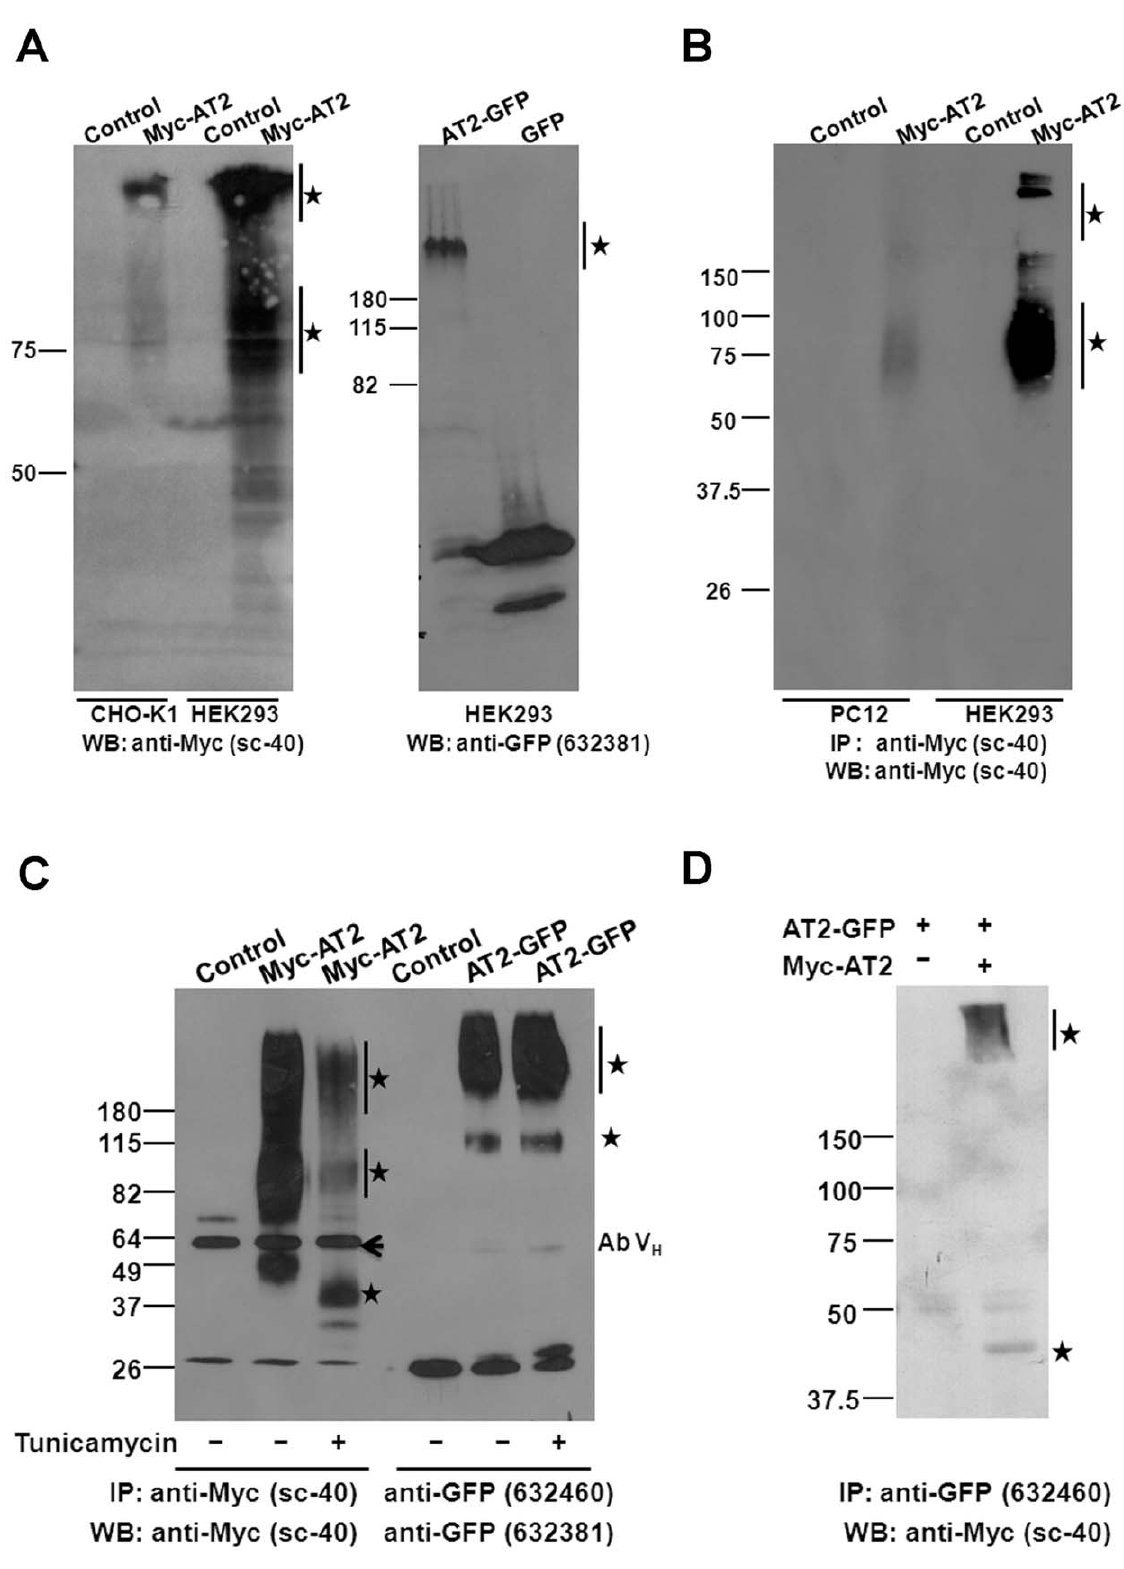
Figure 3. Roles of post-translational processing on cell surface expression of AT2 receptors. (A) Western protein blot analysis of the membrane fraction of cells that stably transfected with epitope-tagged AT2 receptor variants. Cells that stably expressed Myc-AT2 were cultured in 100 mm dish until confluence. Cells were then cultured in serum-free medium overnight the day before cell lysis. Membrane fraction was prepared as described in Methods. Protein blot was probed with an anti-GFP or an anti-Myc antibody as indicated. (B) Cell surface immunoprecipitation of Myc- AT2. Cells were cultured until confluence and then incubated with serum-free medium overnight the day before cell lysis. Cell surface AT2 receptors